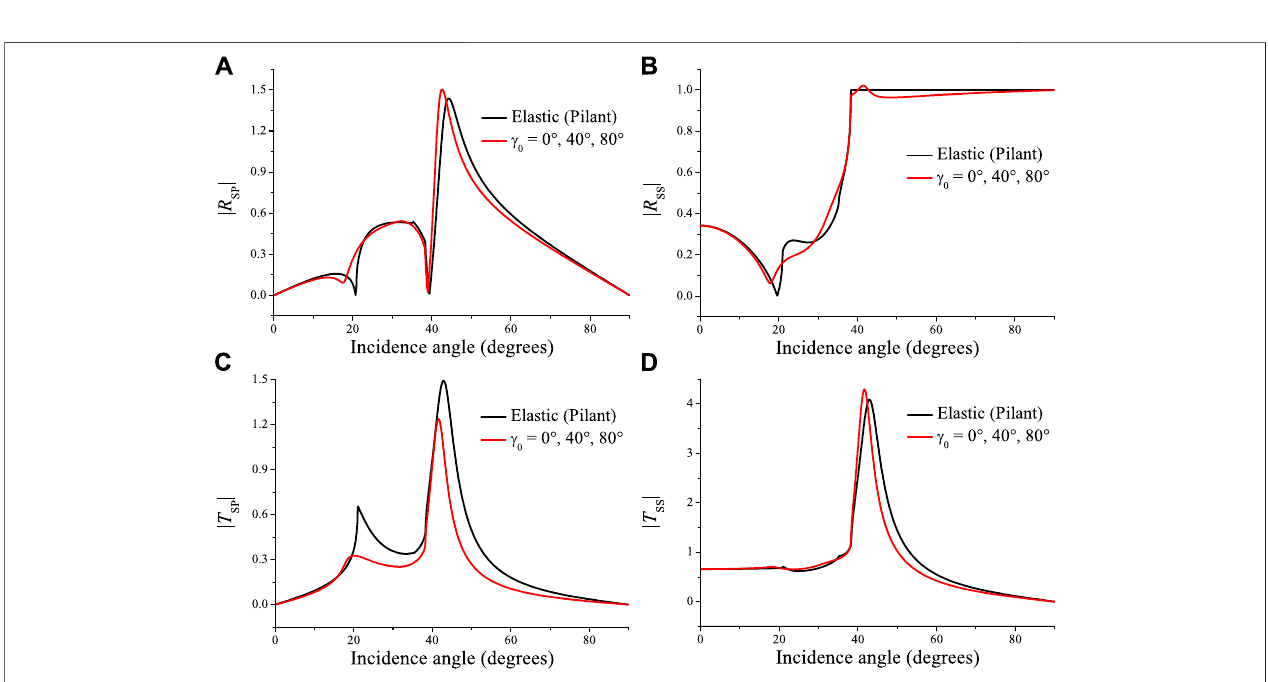
FIGURE 8 | Absolute values of the re fl ected P (A) , re fl ected S (B) , transmitted P (C) and transmitted S (D) waves as a function of the S-wave incidence angle, corresponding to the elastic (black lines) and thermoelastic (red line) cases at 100 MHz for different values of γ 0 .